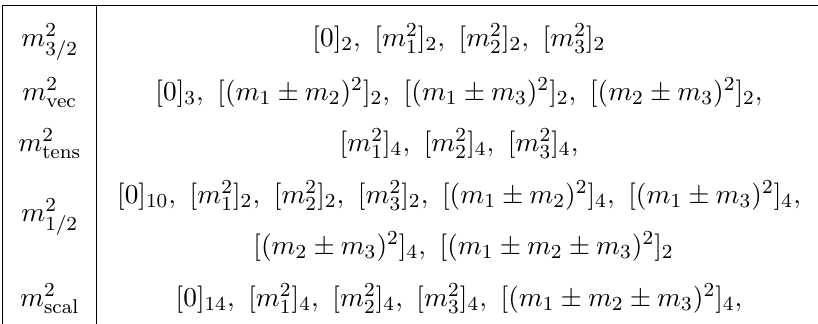
Table 16 . Masses for the Minkowski vacuum M2.